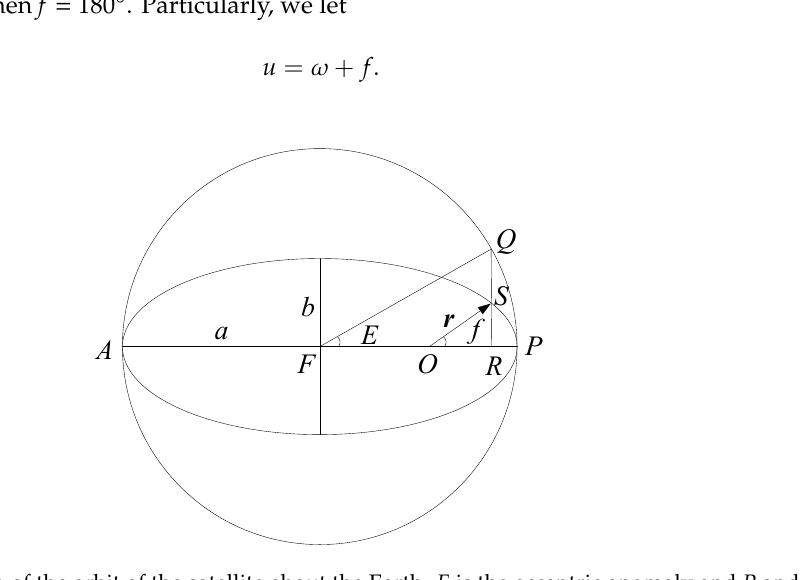
Figure 3. Diagram of the orbit of the satellite about the Earth. E is the eccentric anomaly and P and A are perigee and apogee, respectively.